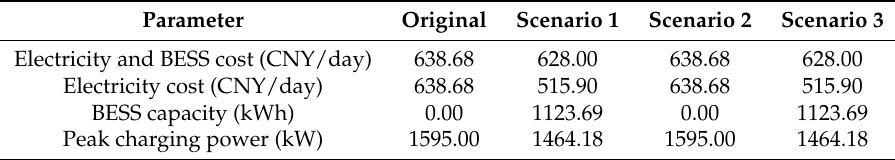
Table 6. Electricity and BESS cost optimization of different BESS configuration scenarios.